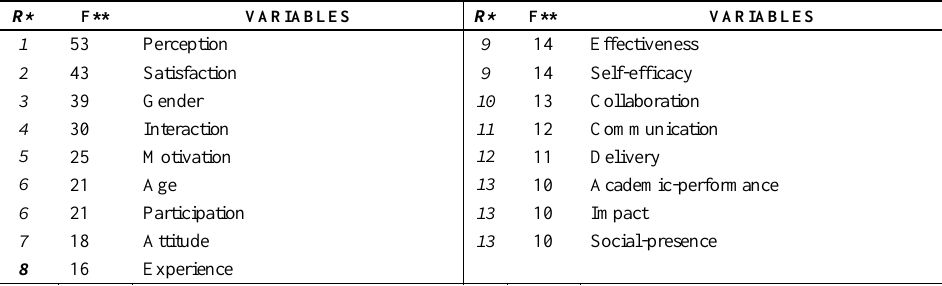
Variables Focused Most Often in the Articles